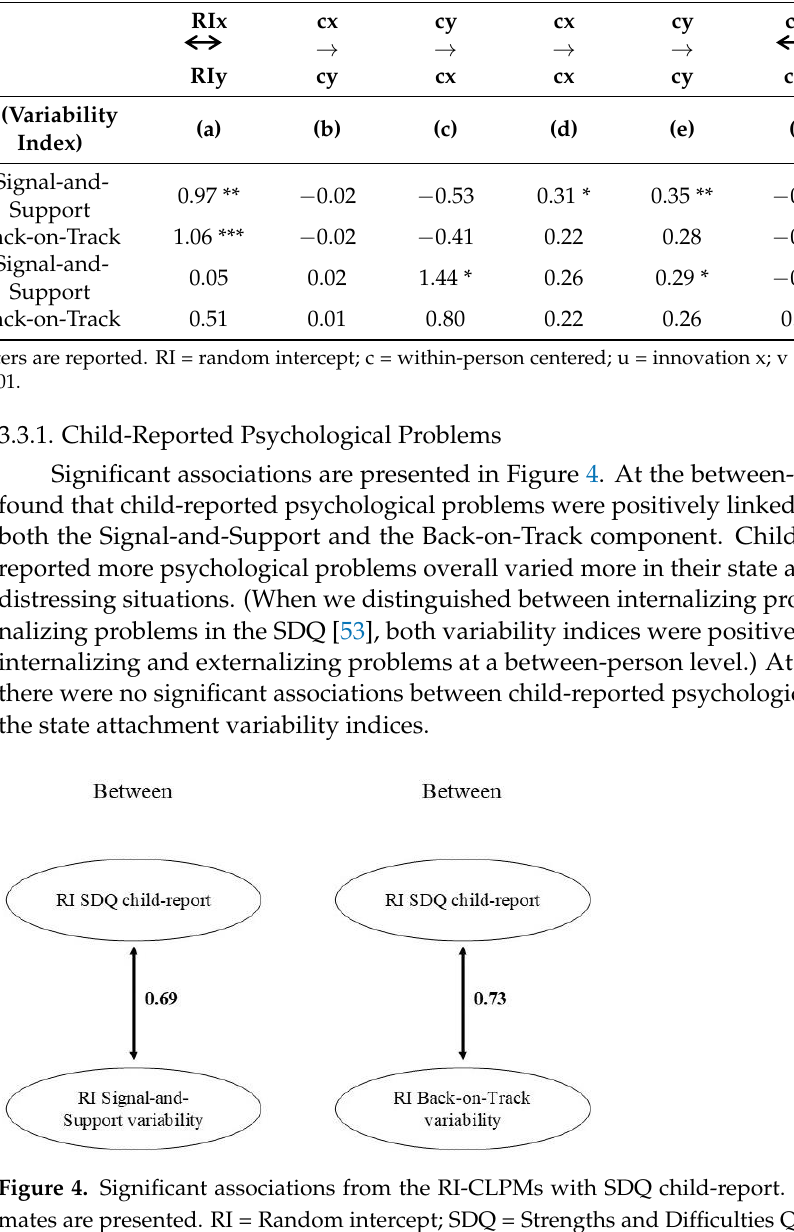
Table 5. RI-CLPM results with Trust.